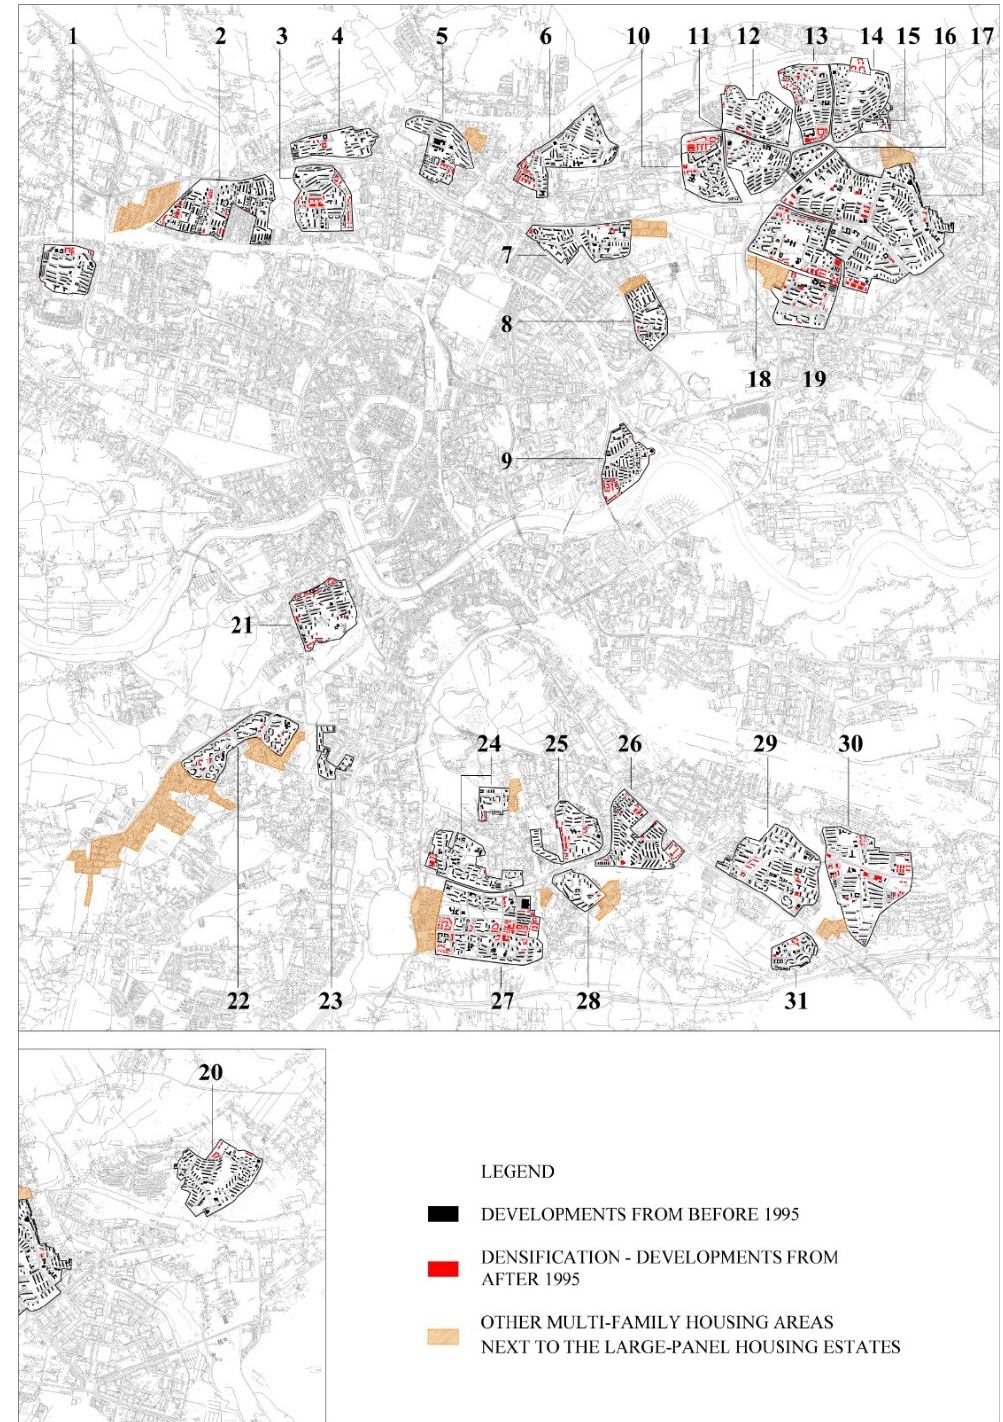
Figure 2. Map of a part of Cracow with areas of the analyzed housing estates marked (black border). 1—Widok, 2—Azory, 3—Krowodrza G ó rka, 4—Pr ˛adnik Biały Zach ó d, 5—Pr ˛adnik Biały Wsch ó d, 6—Pr ˛adnik Czerwony, 7—Olsza II,